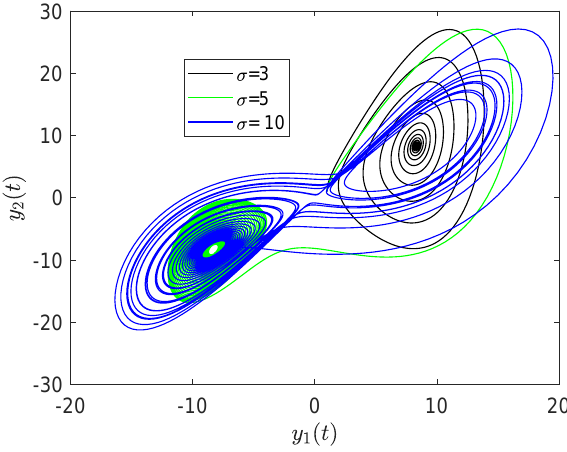
Figure 18. Phase portraits of y 1 and y 2 when varying σ